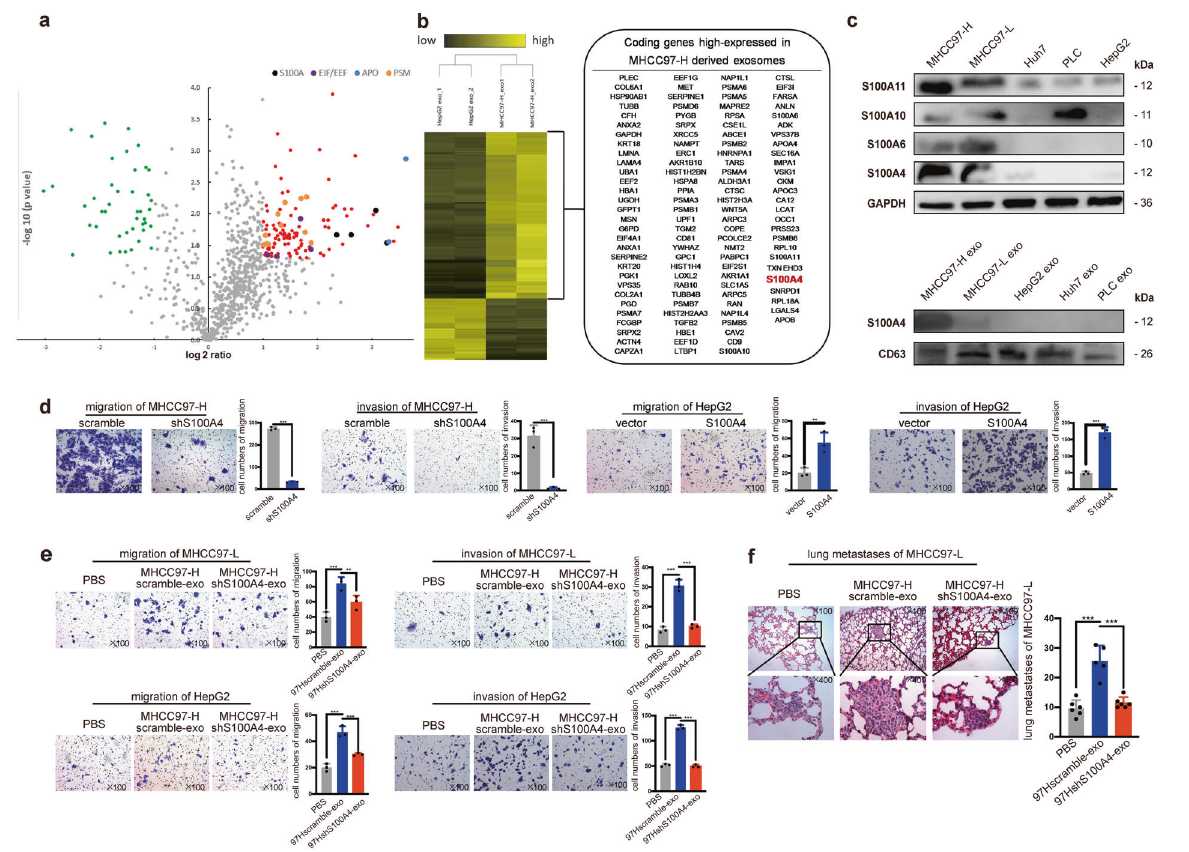
Fig. 3 Exosomal S100A4 is a key promoter to enhance metastatic potential. a iTRAQ mass spectrum screening was performed to analyze the protein cargo of exosomes derived from MHCC97-H (HMH-exosomes) and HepG2 exosomes (LMH-exosomes). Proteins were clustered at the 2-fold changes with a p value less than 0.05. The volcano plots revealed a total 116 up-regulated proteins (right quadrant, generally in red, S100A family in black, EIF/EEF family in purple, APO family in blue and PSM family in orange), and yet 43 proteins were found down-regulated (left quadrant, in green). b The results are also expressed as a heat map, from which 116 up-regulated proteins are shown. c Diverse expression abundance of S100A protein family in HCC cell lines. Western blot showed that expressions of S100A4 were the highest in MHCC97-H among HCC cell lines. S100A4 was only highly expressed in exosomes derived from MHCC97-H. d S100A4 knock-down in MHCC97- H results in inhibited migration and invasion ability. Overexpression of S100A4 enhanced migration and invasion in HepG2. e S100A4 rich exosomes signi fi cantly promotes migration and invasive abilities of cells. Exosomal S100A4 promotes the migration and invasive abilities of cells in vitro. Exosomes of MHCC97-H cells with S100A4 knockdown were de fi ned as S100A4 low exosomes, ones derived from the scrambled counterparts were de fi ned as S100A4 rich exosomes. S100A4 rich exosomes were used to treat MHCC97-L and HepG2 cells for 24 h before migration and invasion assays while PBS and S100A4 low exosomes were used as negative controls. f Exosomal S100A4 promotes the metastatic potential in vivo. MHCC97-L cells treated with PBS, S100A4 rich exosomes or S100A4 low exosomes were injected in nude mice to form lung metastasis model. All the in vitro assays were conducted three times with three repetitions. Error bars represent the mean ± SD, and the dots represent the value of each experiment; * P < 0.05, ** P < 0.01, *** P < 0.001, **** P < 0.0001, ns: no signi fi cance. Statistical signi fi cance was determined by unpaired t